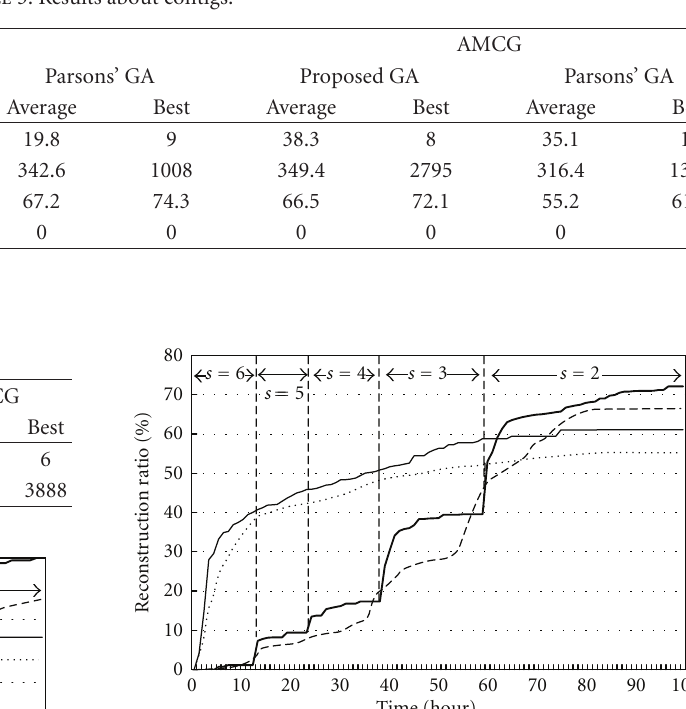
Table 3: Results about contigs.